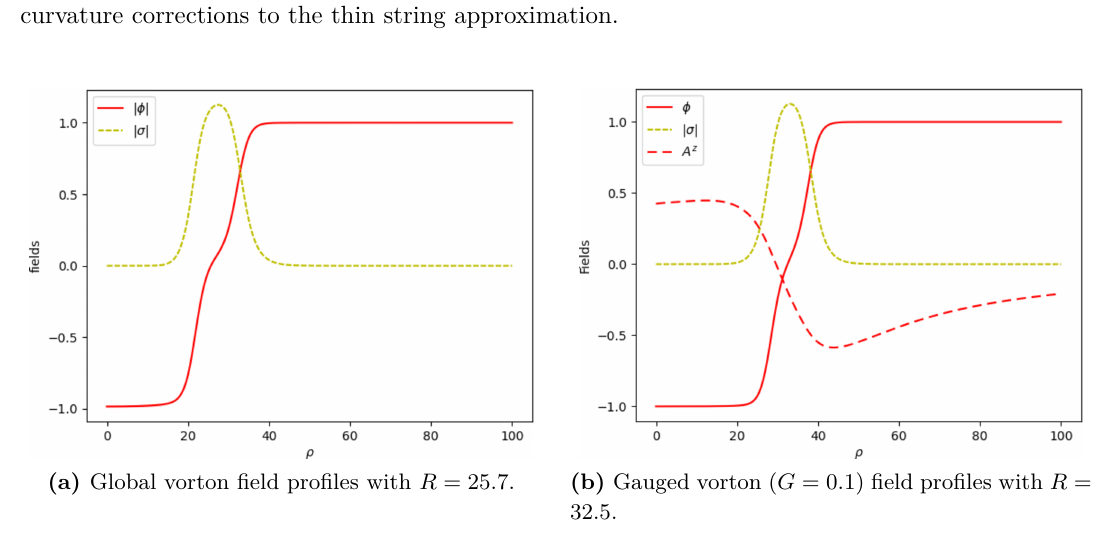
Figure 15 . Q = 9000 , N = 10 vortons with η σ = 1 and λ σ = β = 2 / 3 (parameter sets D and E respectively). There is a significant kink in the vortex field at the string core which is reduced in the gauged model and the inclusion of the gauge fields also act to increase the vorton